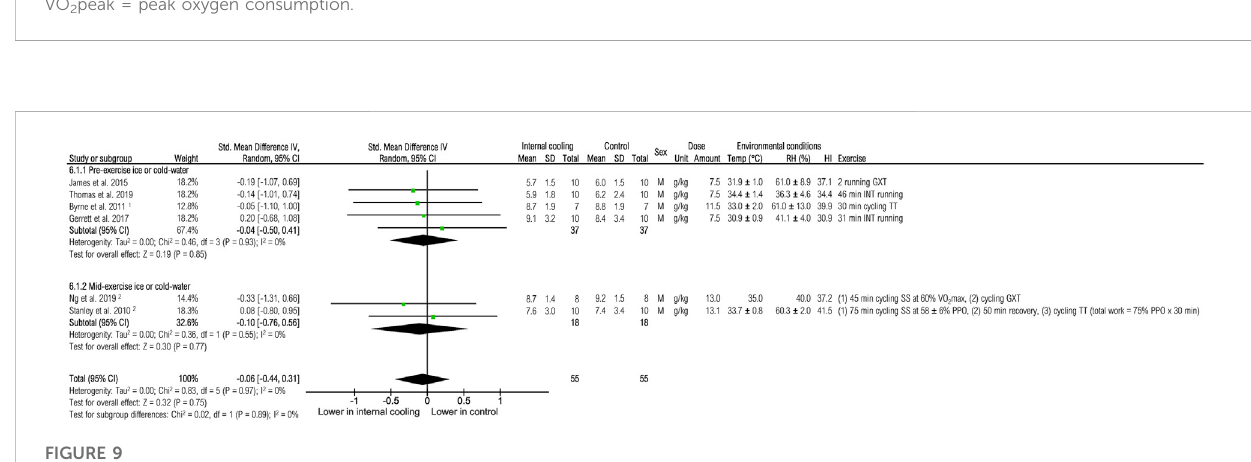
FIGURE 9 Meta-analysisofstandardizedmeandifferenceinbloodlactate[mmol/L]with95%CIbetweeninternalcoolingandcontrol. 1 Studieswithsigni fi cant positive performance effects of internal cooling. 2 Studies with no performance effects of internal cooling. F, female; GXT, graded exercise test; HI, heat index;INT,intermittentexercise;M,male;PPO,peakpoweroutput;RH,relativehumidity,SS,steady-stateexercise;Temp,ambienttemperature;TT,time trial; VO 2 max, maximum oxygen